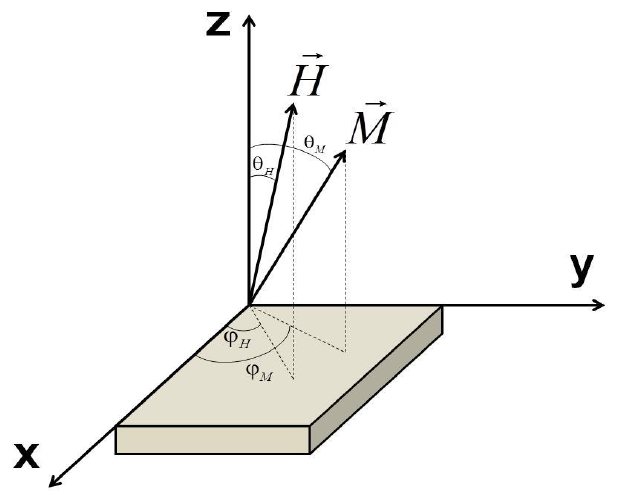
Figure 6. Cartesian frame used for the analysis of orientation dependences of the FMR resonance field.